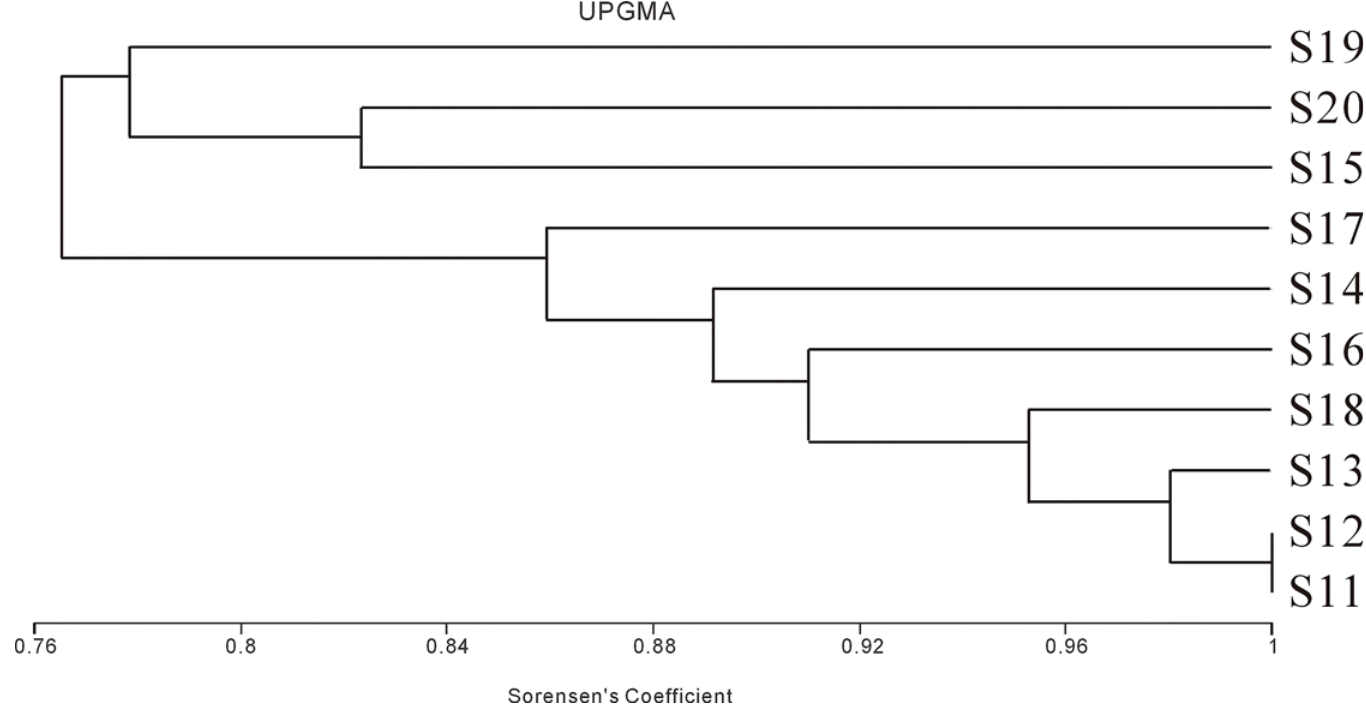
Fig 4. UPGMA dendrogram constructed with DGGE profiles of bacterial 16S rDNA PCR amplification products from rhizosphere soil samples S11-S20. Soil samples were labeled as Table 2. S11, Hulled oat, S12, Mung bean, S13, Foxtail millet, S14, Barley, S15, Rape, S16, Sunflower, S17, Carrot, S18, Flax, S19, Naked oat, S20, Tobacco.